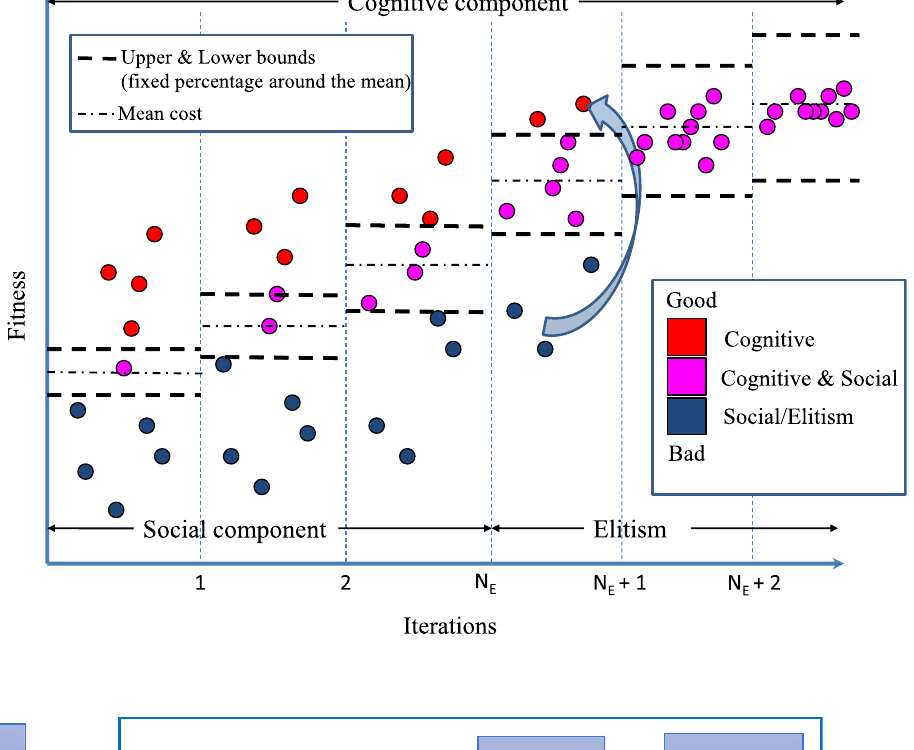
Fig. 2 Particles’ evolution with evolving iterations using the proposed classification with elitism